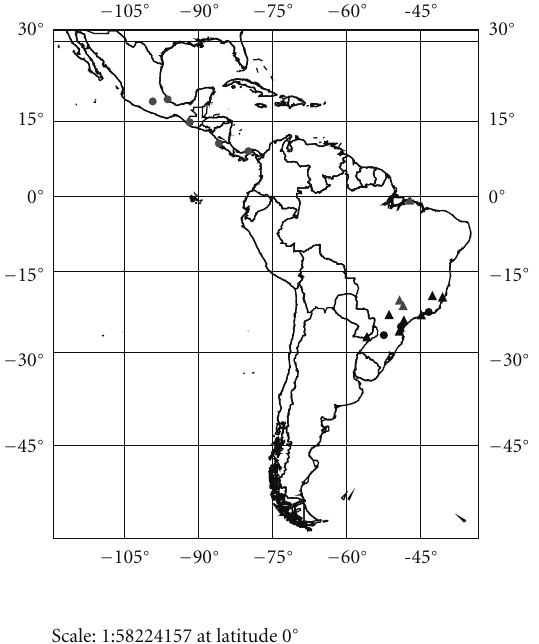
Figure 1: Occurrence records of Epipompilus aztecus (Cresson, 1869) (gray marks) and Epipompilus excelsus (Bradley, 1944) (black marks). The circles represent the old records of the species and the triangle represents the new